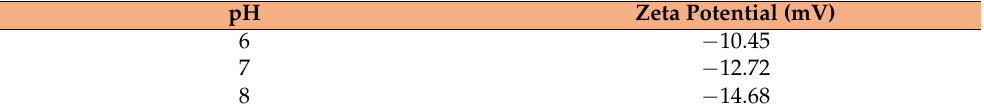
Table 1. Zeta potential values of MMIP at room temperature.